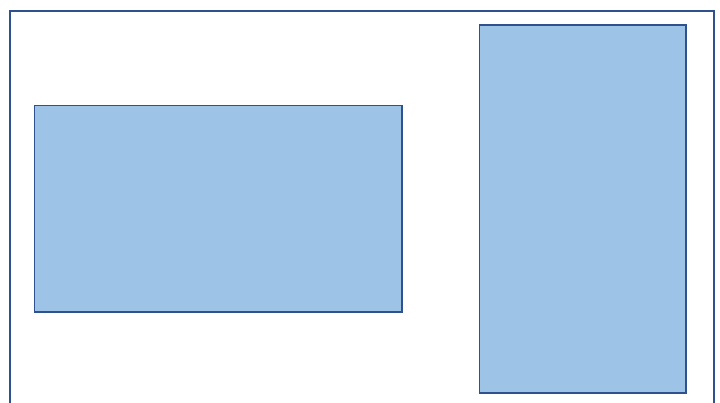
Figure 5. The illustration for the aspect